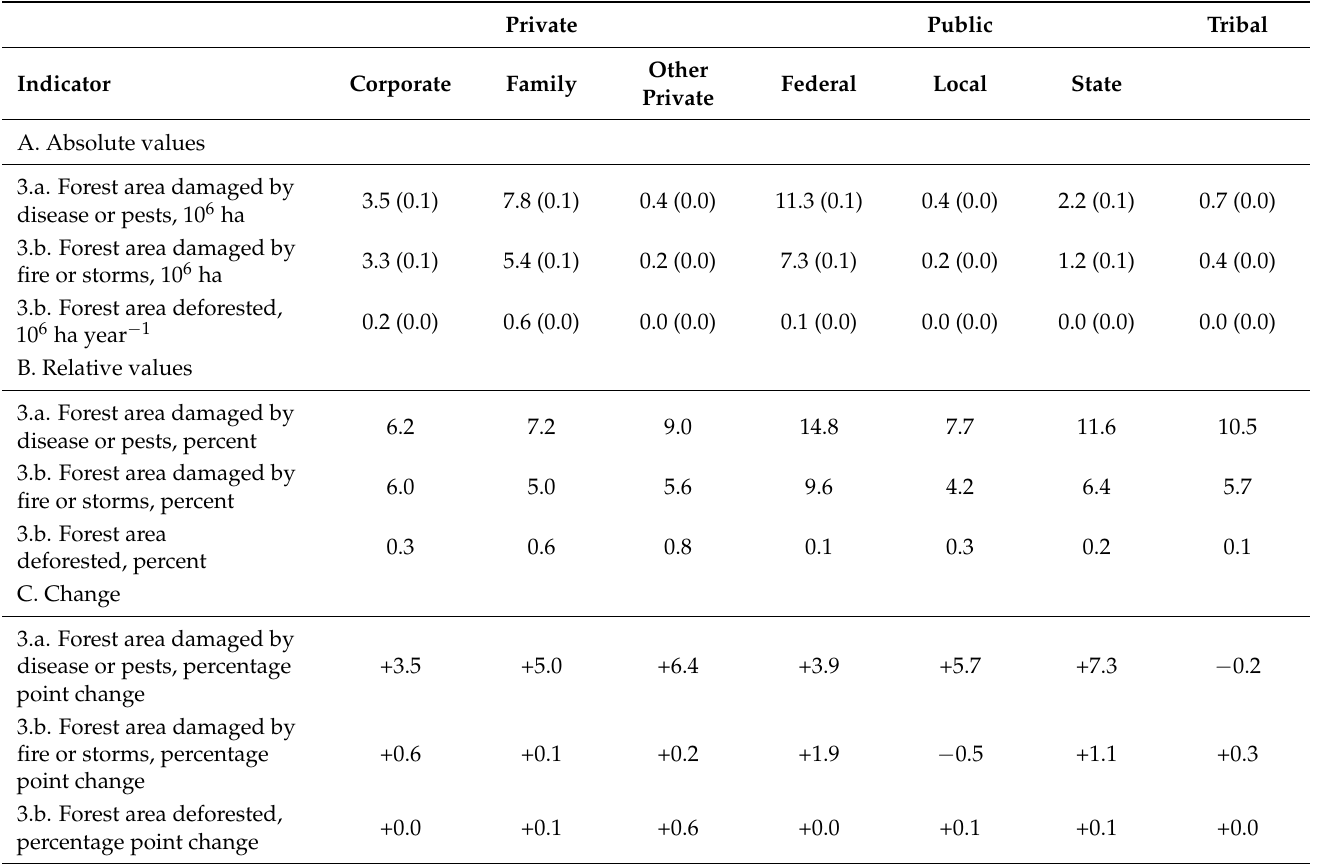
Table 5. Summary of selected Montr é al Process Criterion 3 Indicators by ownership category, conterminous USA in terms of: (A) absolute values (2019), (B) relative values (2019), and (C) change (2012–2019). Indicators, including data sources, are described in Table 1. Where available, standard errors are listed parenthetically following the